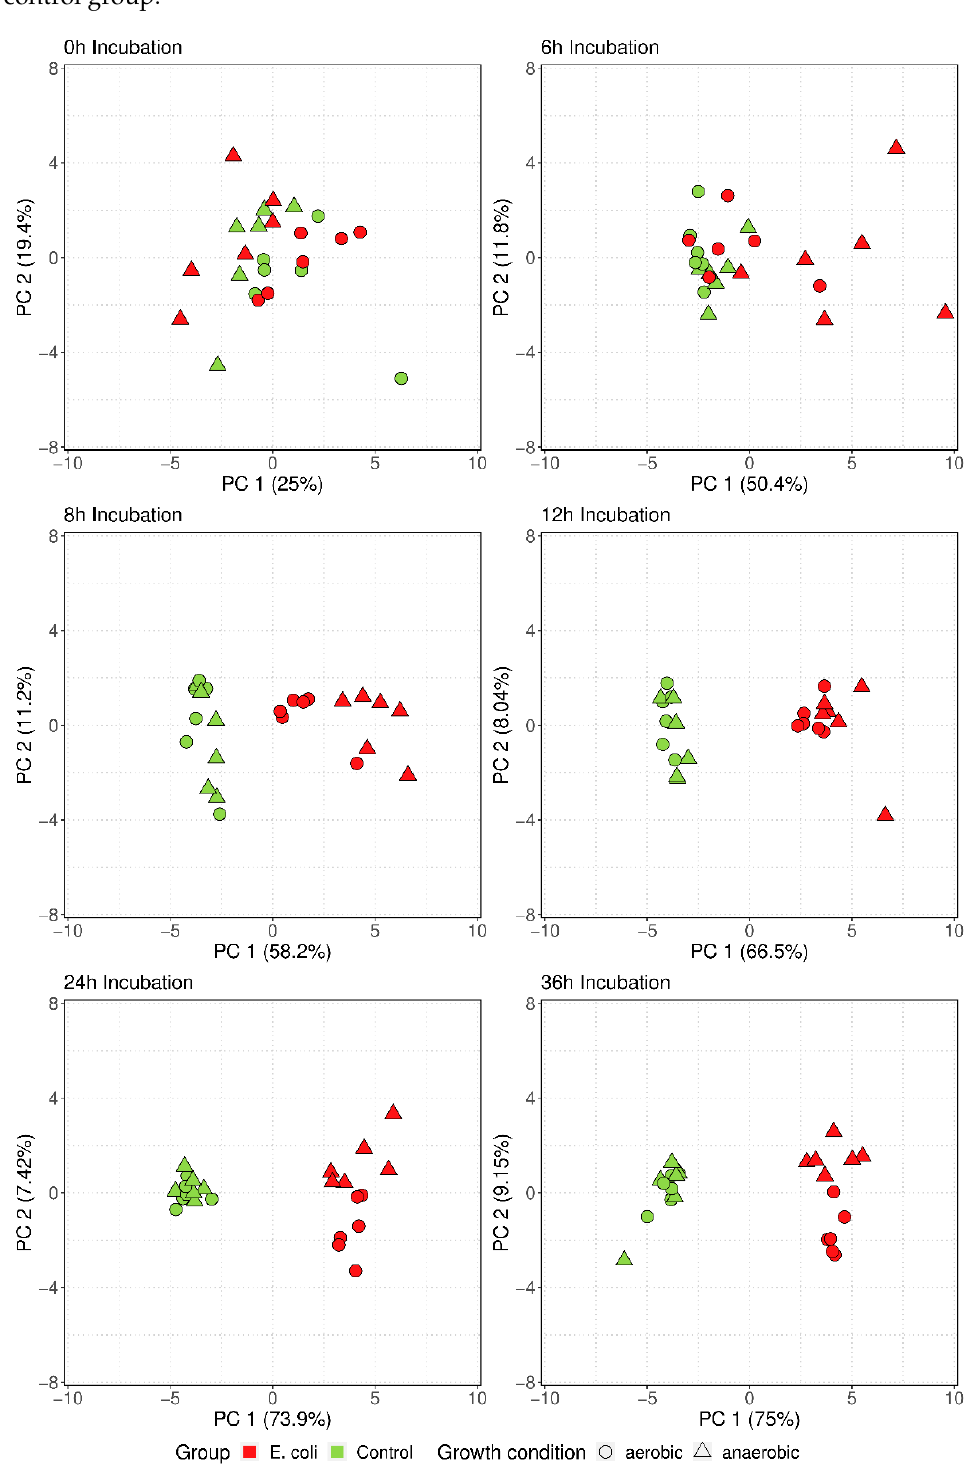
Figure 5. PCA biplots for timepoints 0, 6, 8, 12, 24, and 36 h incubation time showing the development of differentiation after 6 h in anaerobic media and after 8 h in aerobic media. Each point represents one BC sample.